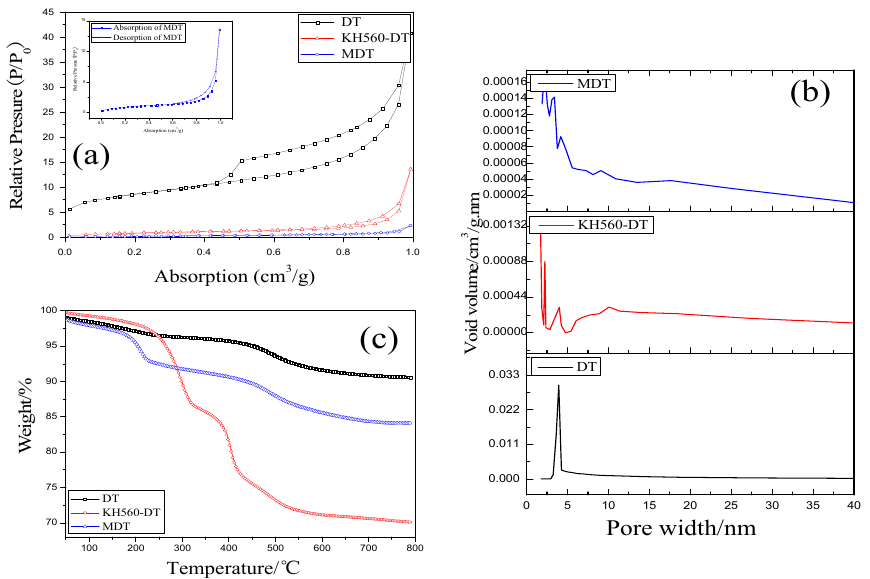
Figure 3. BET ( a ); porosity distribution ( b ); and thermal stability ( c ) of different types of DT.